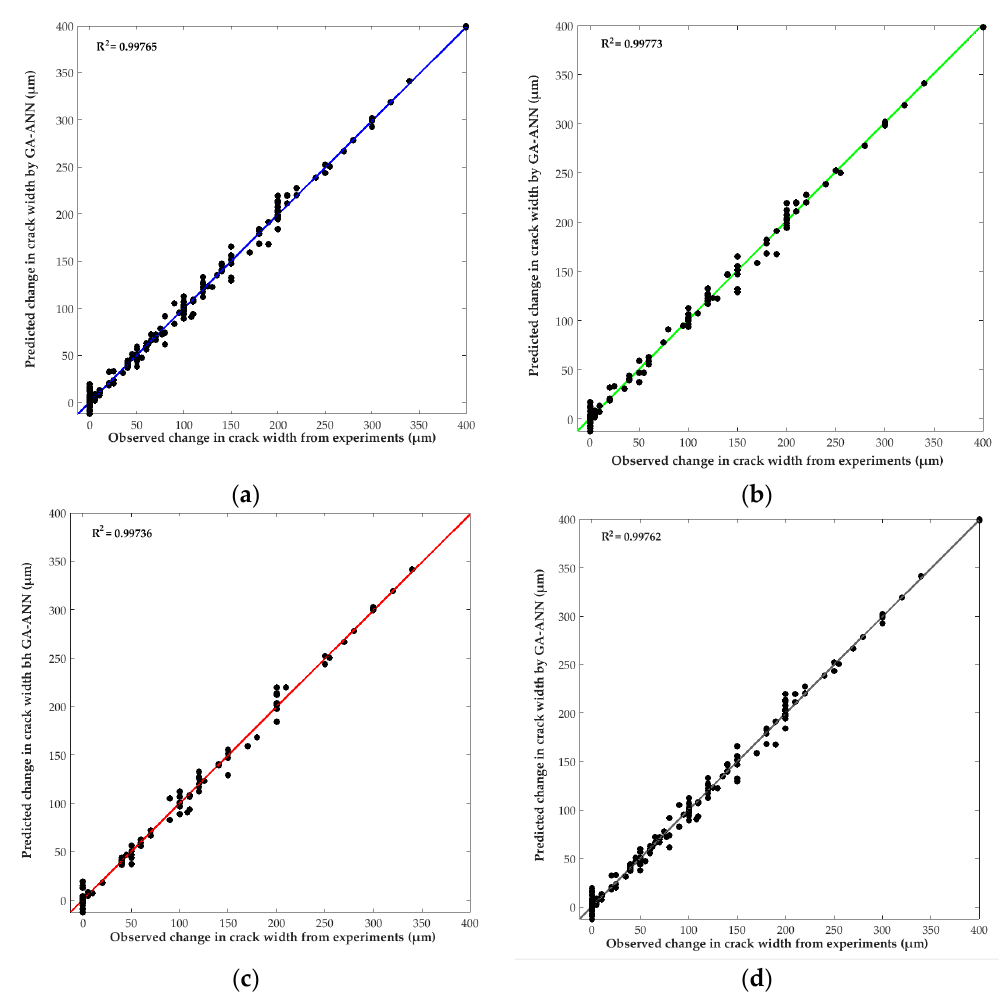
Figure 4. Regression plot of GA–ANN predicted change in crack width due to self-healing versus the corresponding experimentally observed change in crack width: ( a ) training; ( b ) validation; ( c ) test; and ( d ) complete data set.